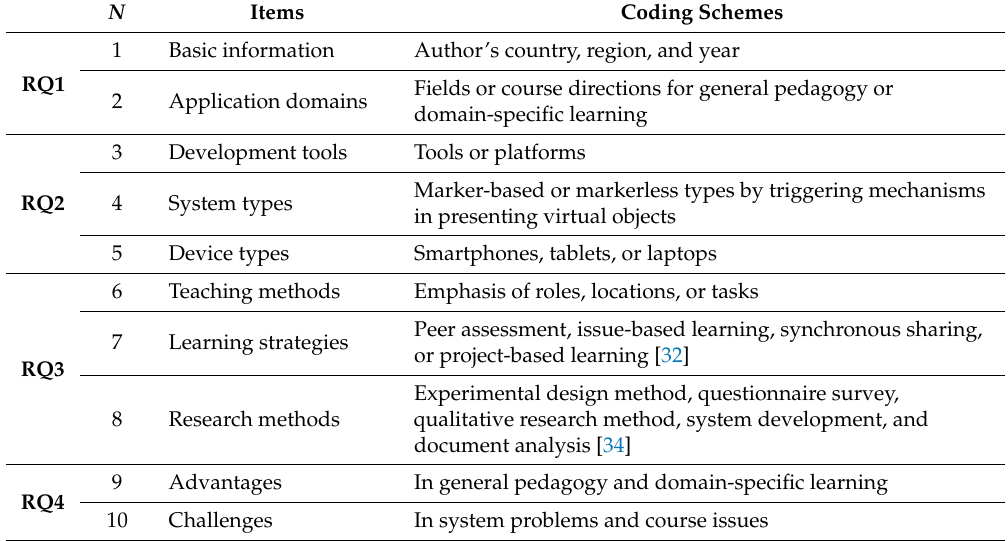
Table 2. Reference and description of the coding scheme.